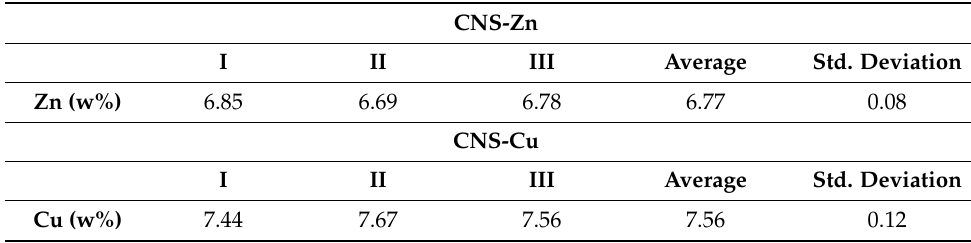
Table 1. ICP-OES analysis result for the sample before the reactions. I, II and III indicate three different samples on which measurements were performed.